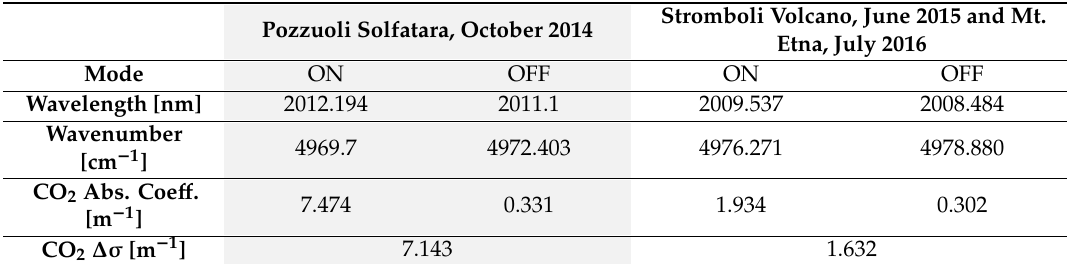
Table 2. Wavelengths, wavenumbers, and CO 2 absorption coe ffi cients calculated (at T = 296 K, P = 1 atm) during the field campaigns of Pozzuoli Solfatara, Stromboli volcano, and Mt.